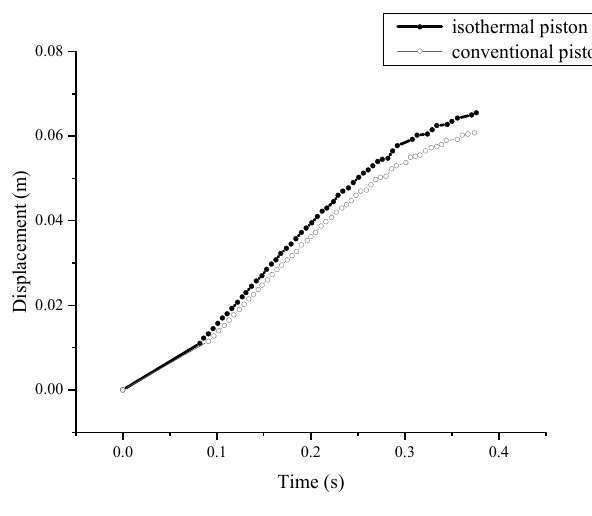
Figure 10. Piston displacement.